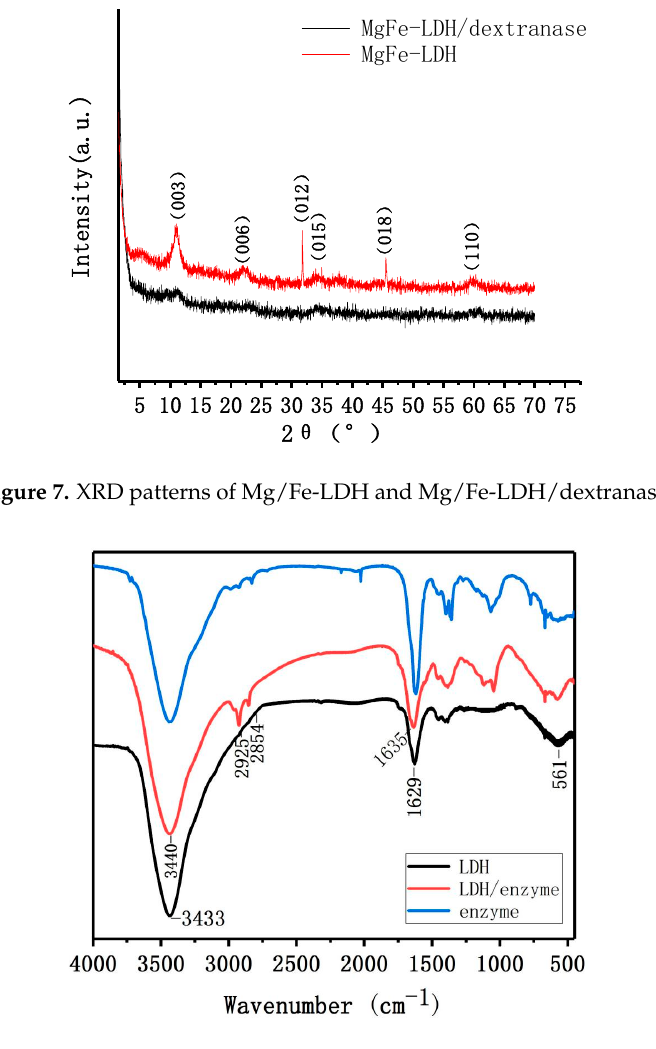
Figure 8. FTIR patterns for Mg/Fe-LDH, Mg/Fe-LDH/dextranase, and dextranase.